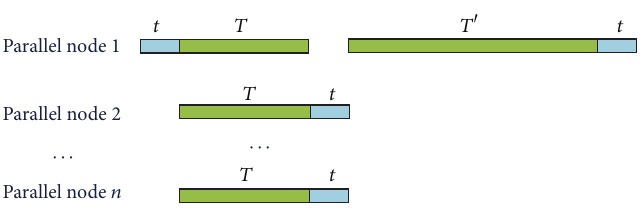
Figure 9: The computing cycle in the improved scheme.